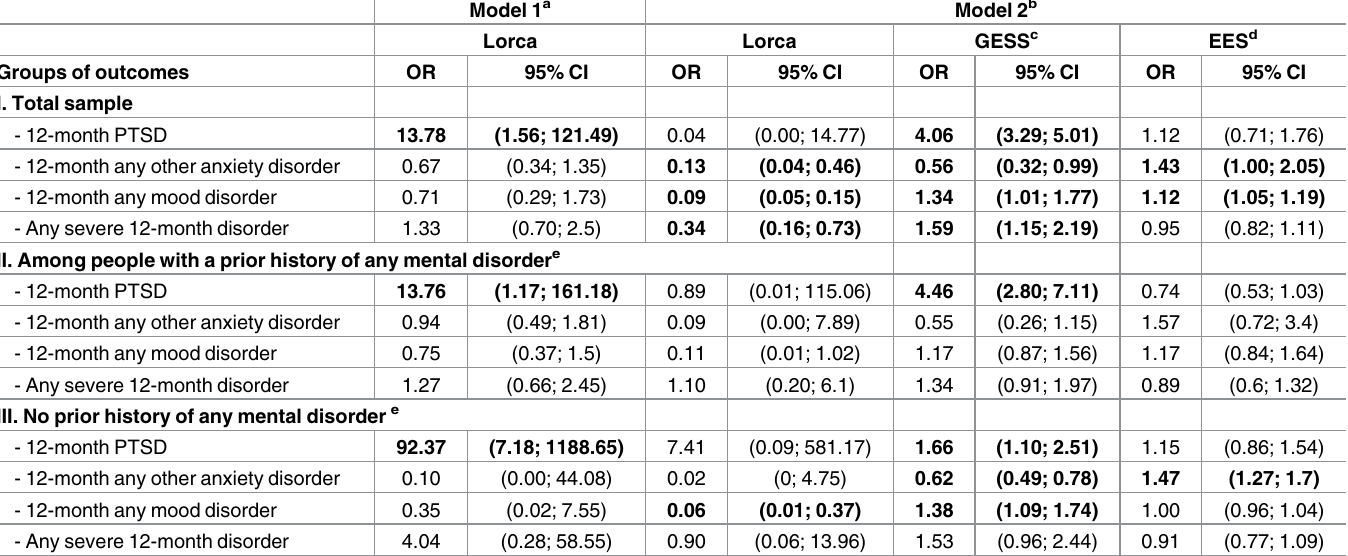
Table 4. Multivariate logistic regression analysesof 12-month of PTSD, any other anxiety, mood and any severe12-month disorder in Lorca com- pared to the rest of